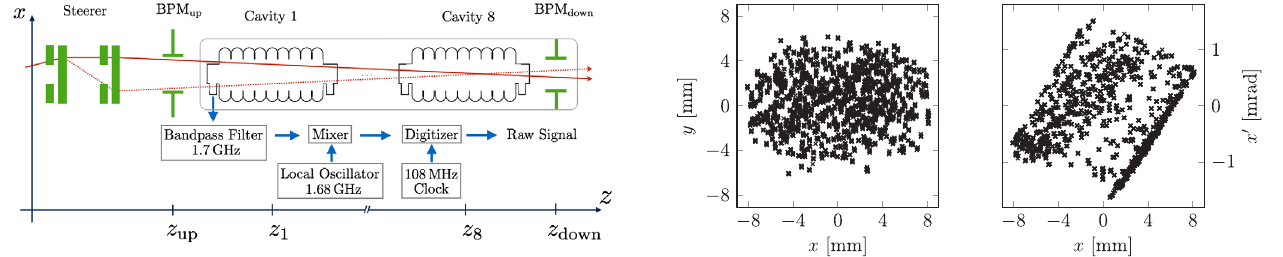
FIG. 6. Beam position and angle as calculated for the first cavity of ACC2 at FLASH during a HOM-based cavity misalign- ment measurement. The x - y plane (left) and the x - x 0 plane (right) for 3300 trajectories are plotted. For each plane, two steerers are driven randomly within a defined range, giving, e.g., in the x - x 0 -plane a tilted rectangular shape. Its inhomogeneous filling is due to beam losses.